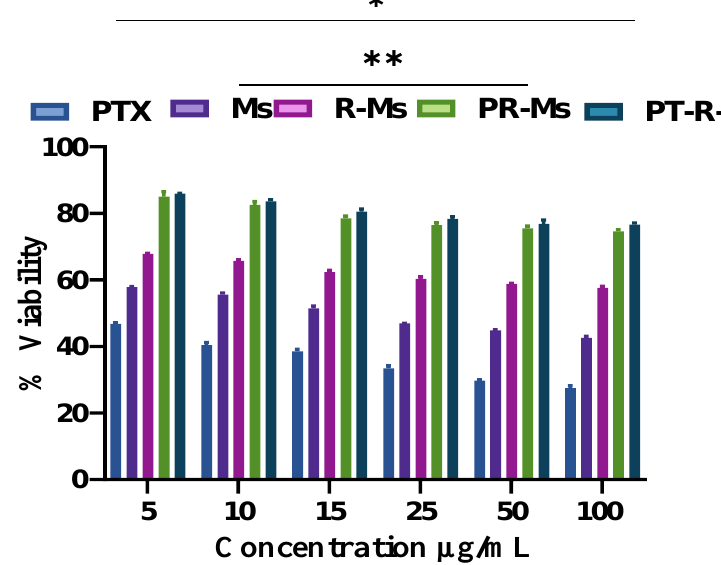
Figure 8. Biocompatibility analysis of Ms, R-Ms, P-R-Ms, and PT-R-Ms at different concentrations to evaluate the toxicity against macrophages isolated from fresh human blood via MTT assay. Results are shown as mean ± SD, ( n = 3), p < 0.05 (*), p < 0.01 (**).